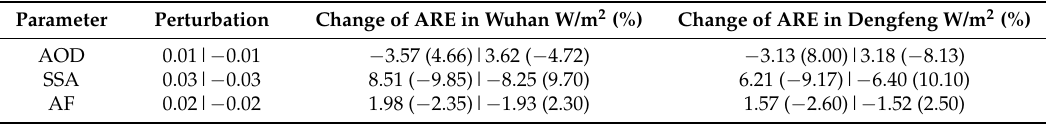
Table 1. Aerosol parameter perturbations used in radiative perturbation analysis and corresponding ARE changes (relative deviation is indicated by